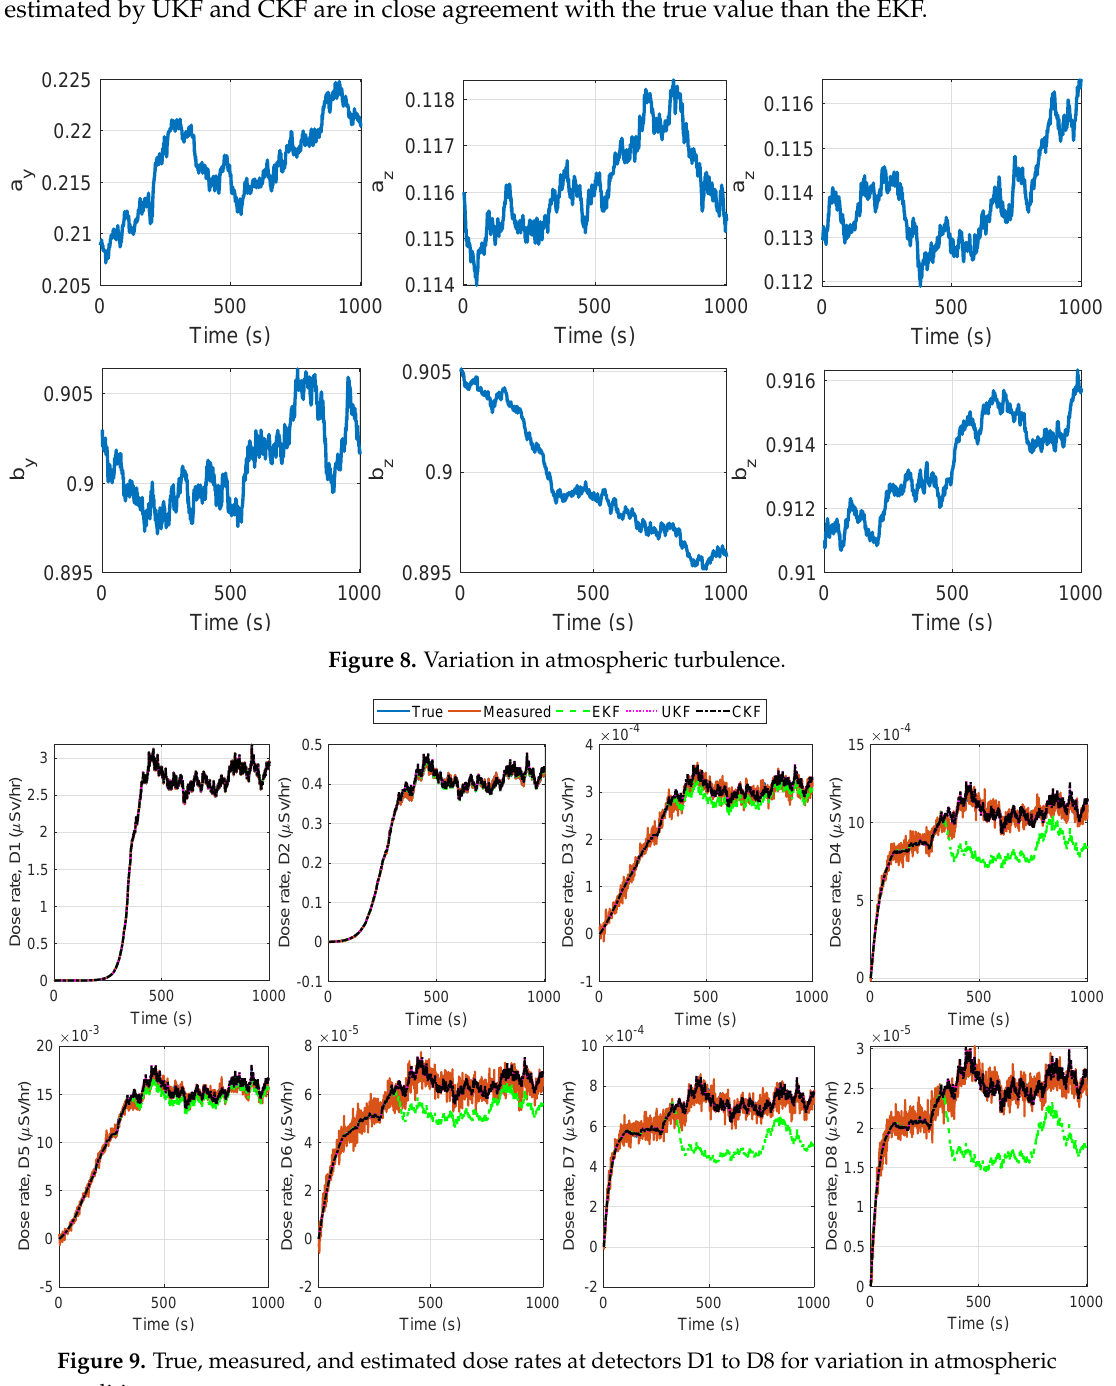
Figure 9. True, measured, and estimated dose rates at detectors D1 to D8 for variation in atmospheric